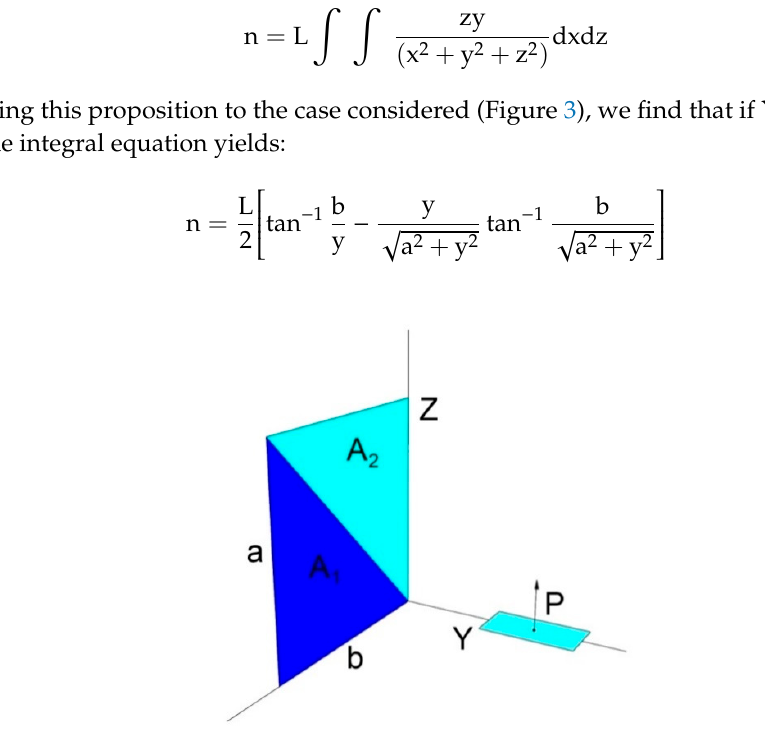
Figure 3. Configuration factor between a rectangle consisting of two annexed triangles (A 1 and A 2 ) and a point aligned with the normal to a vertex and contained in a plane perpendicular to the figure.